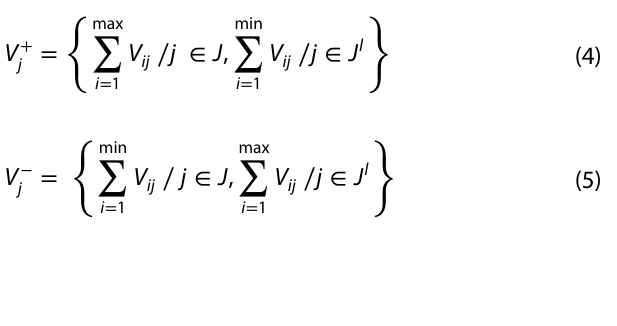
Table 4 RSM-CCD layout and their experimental values